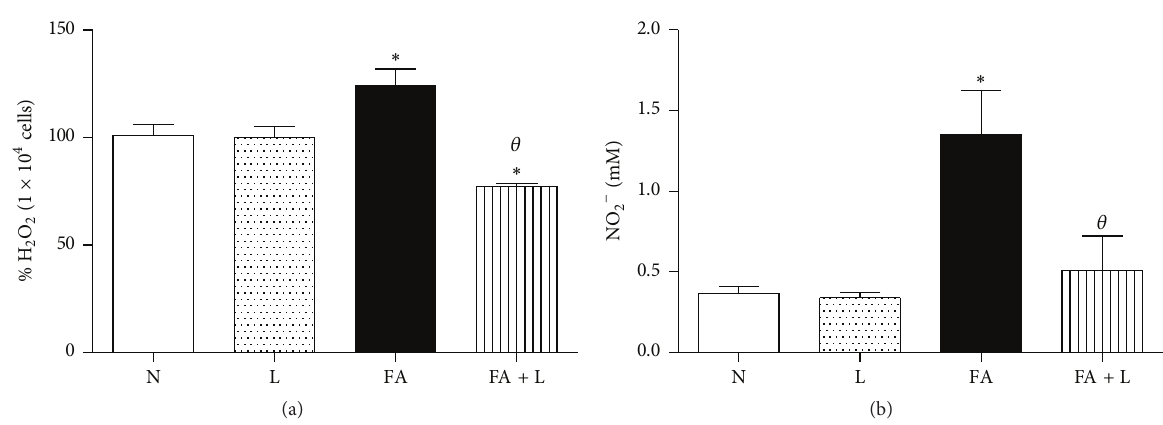
Figure 1: Photobiomodulation therapy reduces generation of H 2 O 2 and NO 2 after FA exposure in the lung. Group of rats was exposed or not to FA inhalation (1%, 90 min/day, 3 days) and treated or not with laser (30 mW, 1.8J, 60 s/point, total 540s, 1 and 5 h after each FA inhalation). In parallel, group of rats were treated only with laser and nonmanipulated rats were used to obtain basal parameters. The quantification of H 2 O 2 and NO 2 (a, b) was determined 24 h after the last FA inhalation. Data mean ± SEM of 6 animals per group. ∗ 𝑃 < 0.05 in relation to N and L groups; 𝜃 𝑃 < 0.05 in relation to FA group.